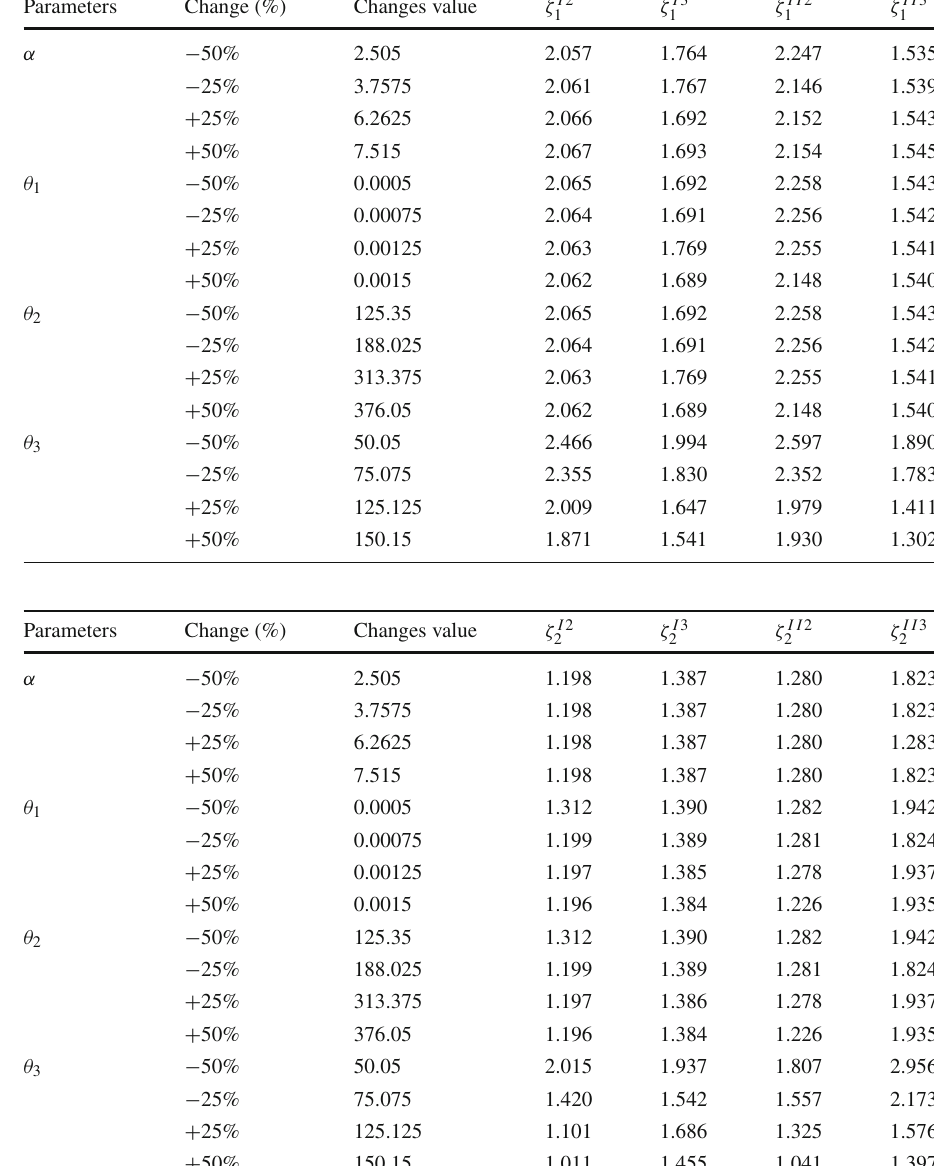
Table 6 Parameters changes value versus manufacturer’s